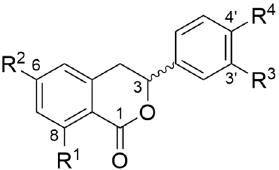
Figure 3. ESI-HDMS E fragmentation of ( A ) thunberginol C ( 9 ), and ( B ) 2,4-dihydroxy-6-[2-(4- hydroxyphenyl)ethyl]benzoic acid ( 15 ).